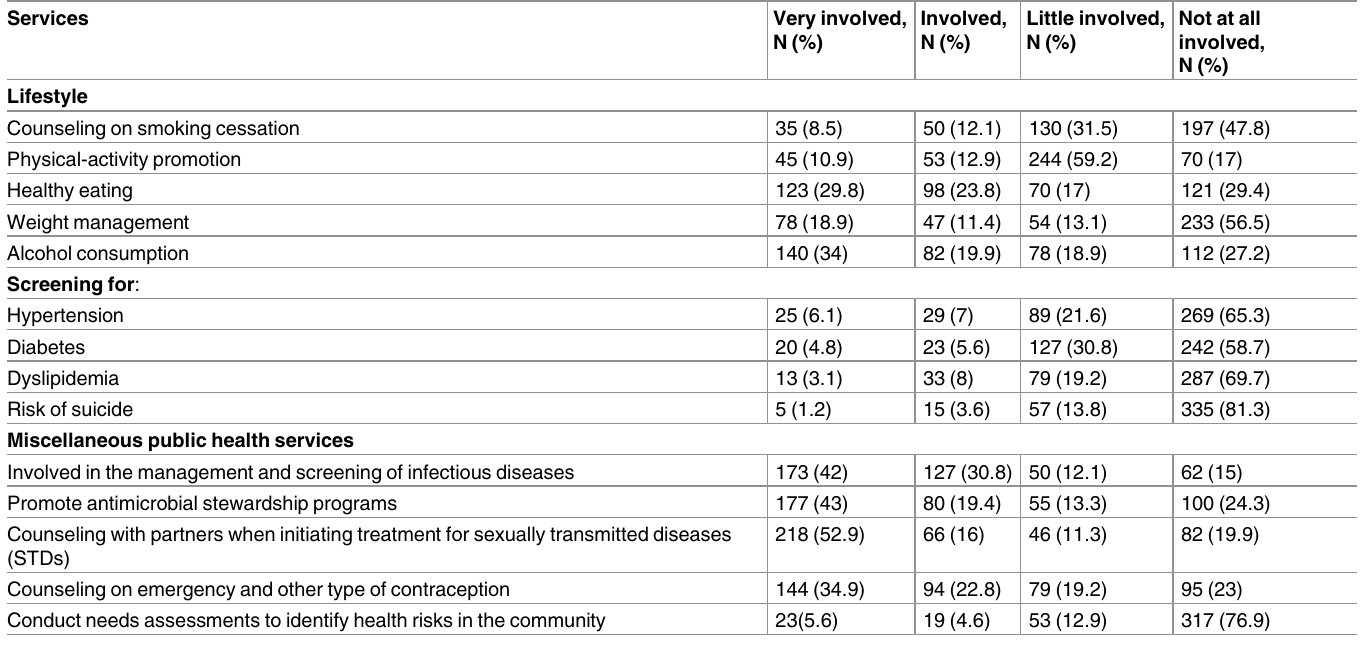
Table 2. Levels of involvement of community pharmacyprofessionals in public health services,Amhara, Ethiopia, N = 412. Services